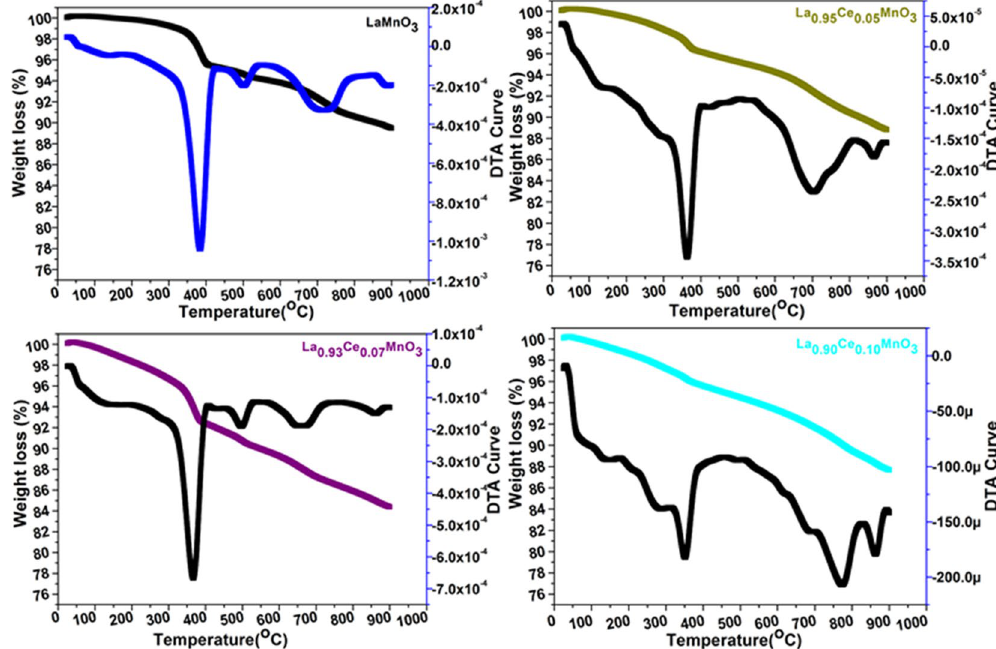
Figure 3. Thermogravimetric analysis of LaMnO 3 , La 0.95 Ce 0.05 MnO 3 , La 0.93 Ce 0.07 MnO 3 and La 0.90 Ce 0.10 MnO 3 nanoparticles.